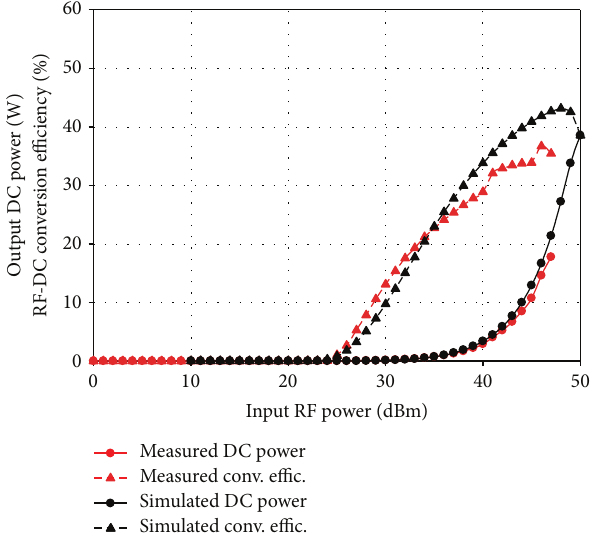
Figure 16: Simulated and measured input-output characteristics of the rectifier.